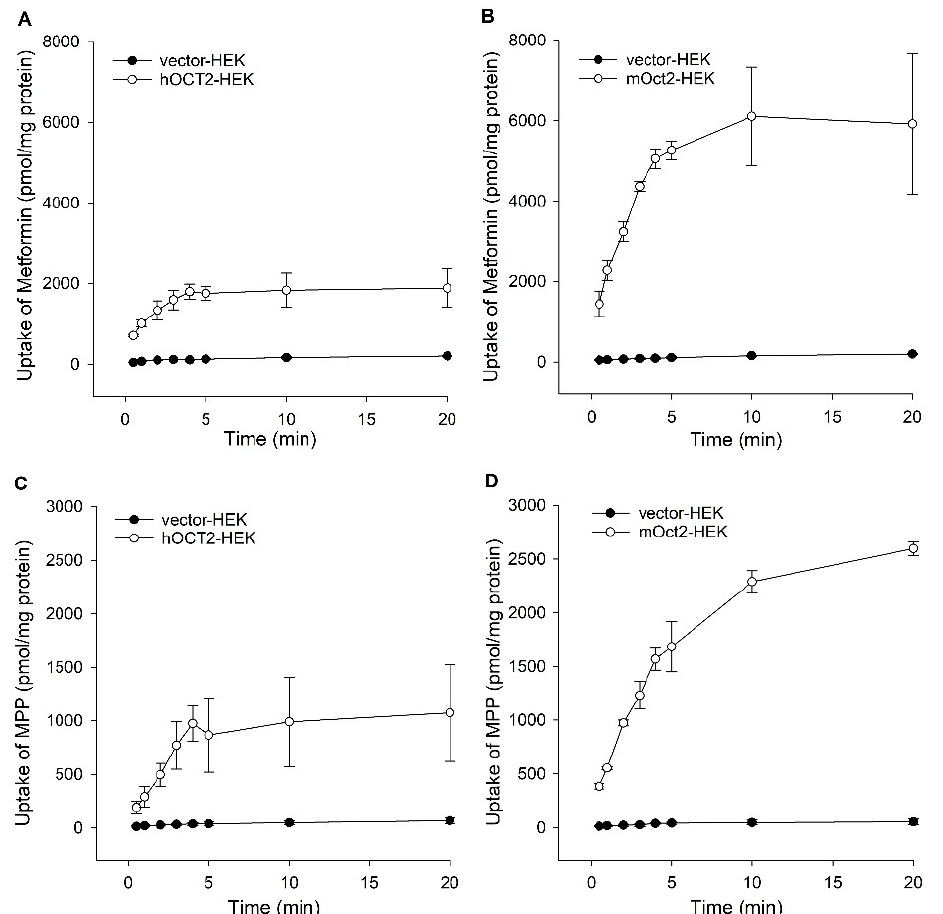
Figure 1. Time-dependent uptake of 100 µ M metformin in ( A ) hOCT2-, ( B ) mOct2- 10 µ M MPP in Figure 1. Time ‐ dependent uptake of 100 μ M metformin in ( A ) hOCT2 ‐ , ( B ) mOct2 ‐ 10 μ M MPP in ( C ) hOCT2-, ( D ) mOct2-, and corresponding vector controls. Data are presented as the mean of two ( C ) hOCT2 ‐ , ( D ) mOct2 ‐ , and corresponding vector controls. Data are presented as the mean of two independent experiments carried out in triplicate ± average independent experiments carried out in triplicate ± average deviation.